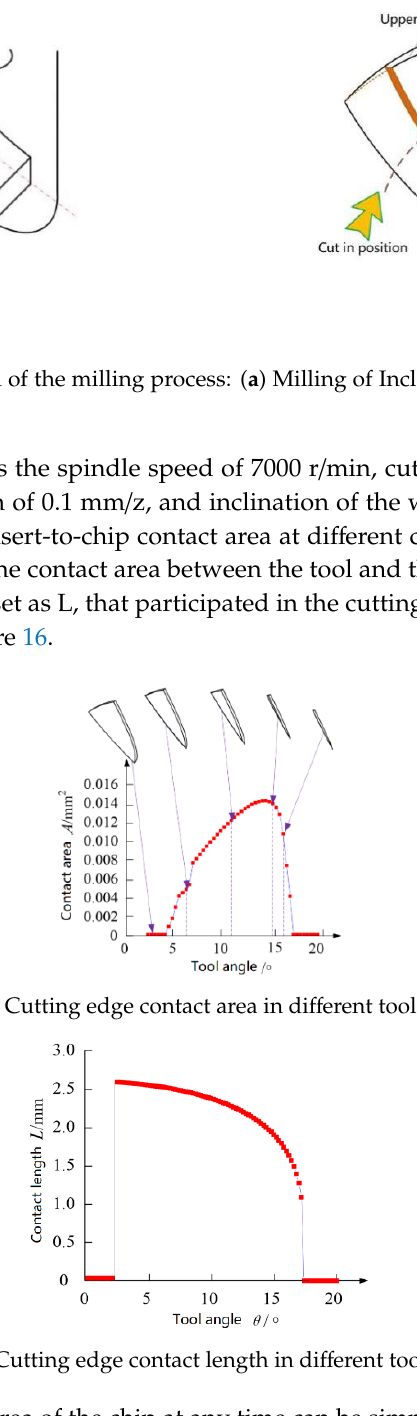
Figure 16. Cutting edge contact length in different tools angles.